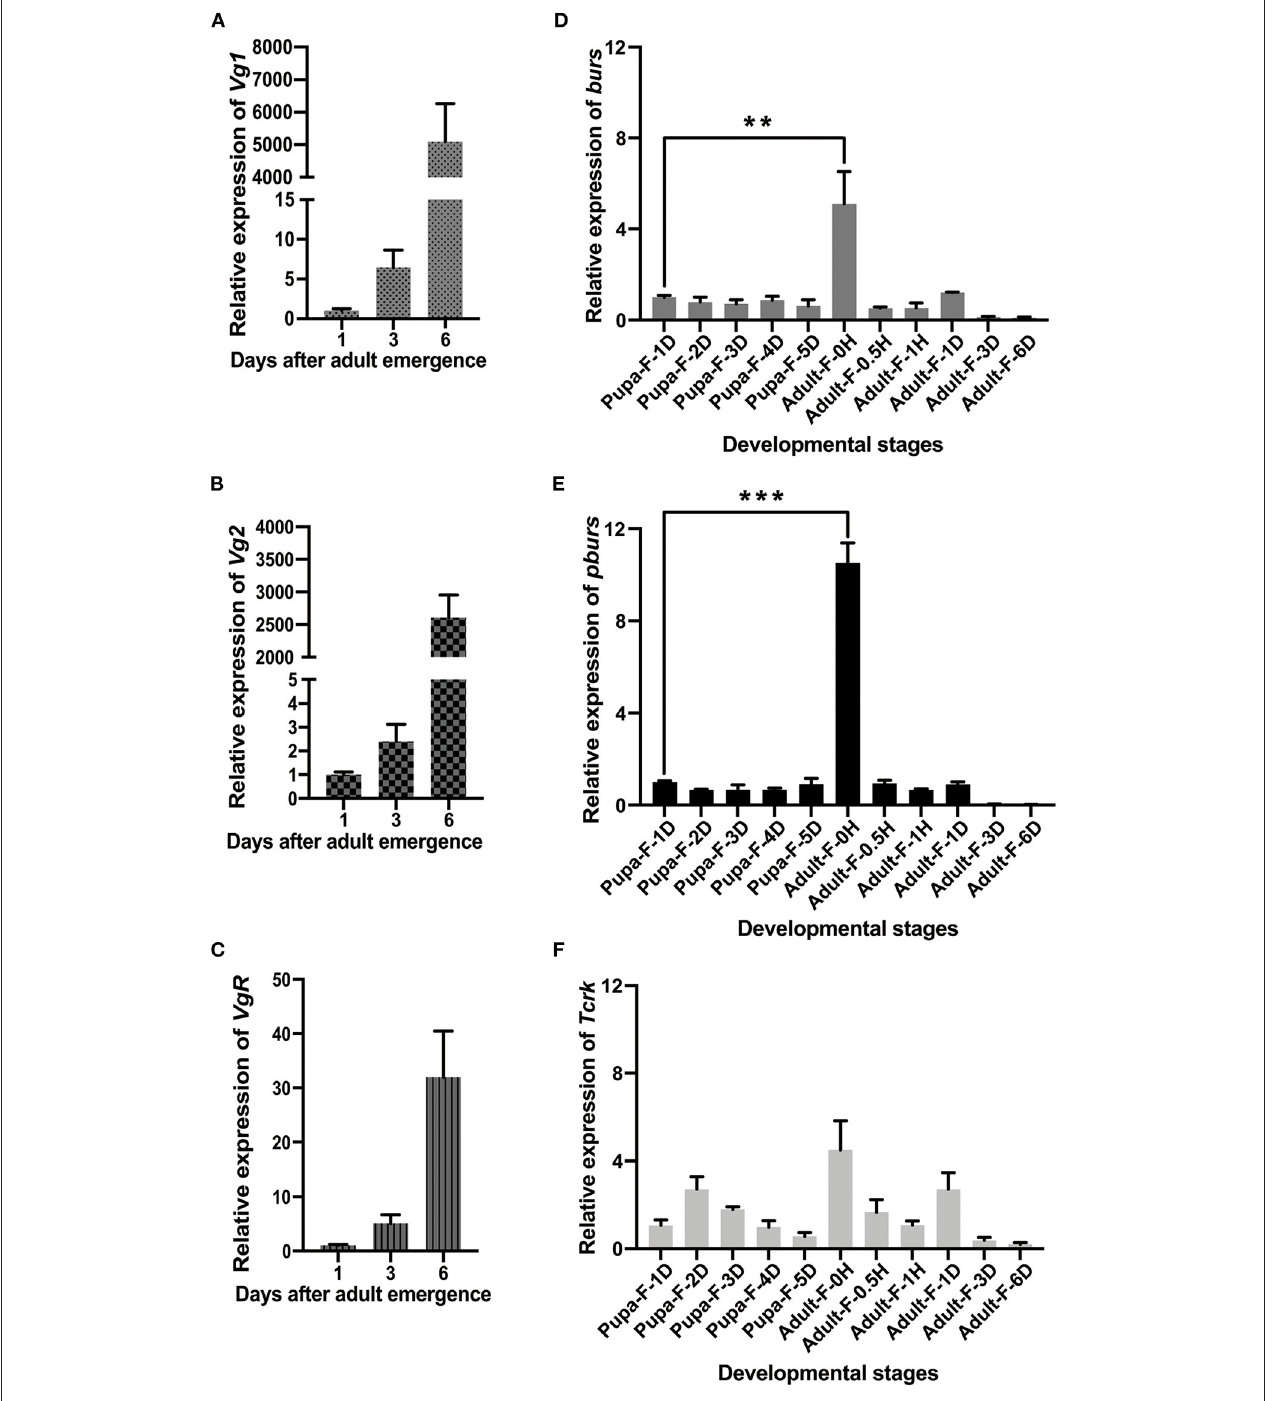
FIGURE 1 | Developmental expression profiles of Vg1 , Vg2 , Vg receptor ( VgR ), bursicon ( burs ), partner of burs ( pburs ), and buricon receptor T. castaneum rickets (Tcrk) . (A–C) Relative expression levels of Vg1 , Vg2 , and VgR in 1-, 3-, and 6-day females. (D–F) Relative expression levels of burs , pburs , and Tcrk from the pupal to the adult stage. The bars represent the mean ± SEM. The asterisks above bars indicate significant differences between the treatment and the corresponding control, ** p < 0.01, *** p < 0.001 by t- test.